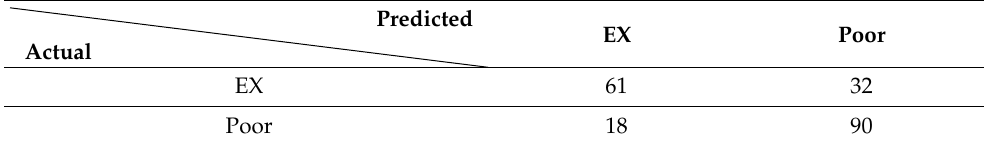
Table 8. Confusion matrix of C5.0 in Case 3 (fold 1).